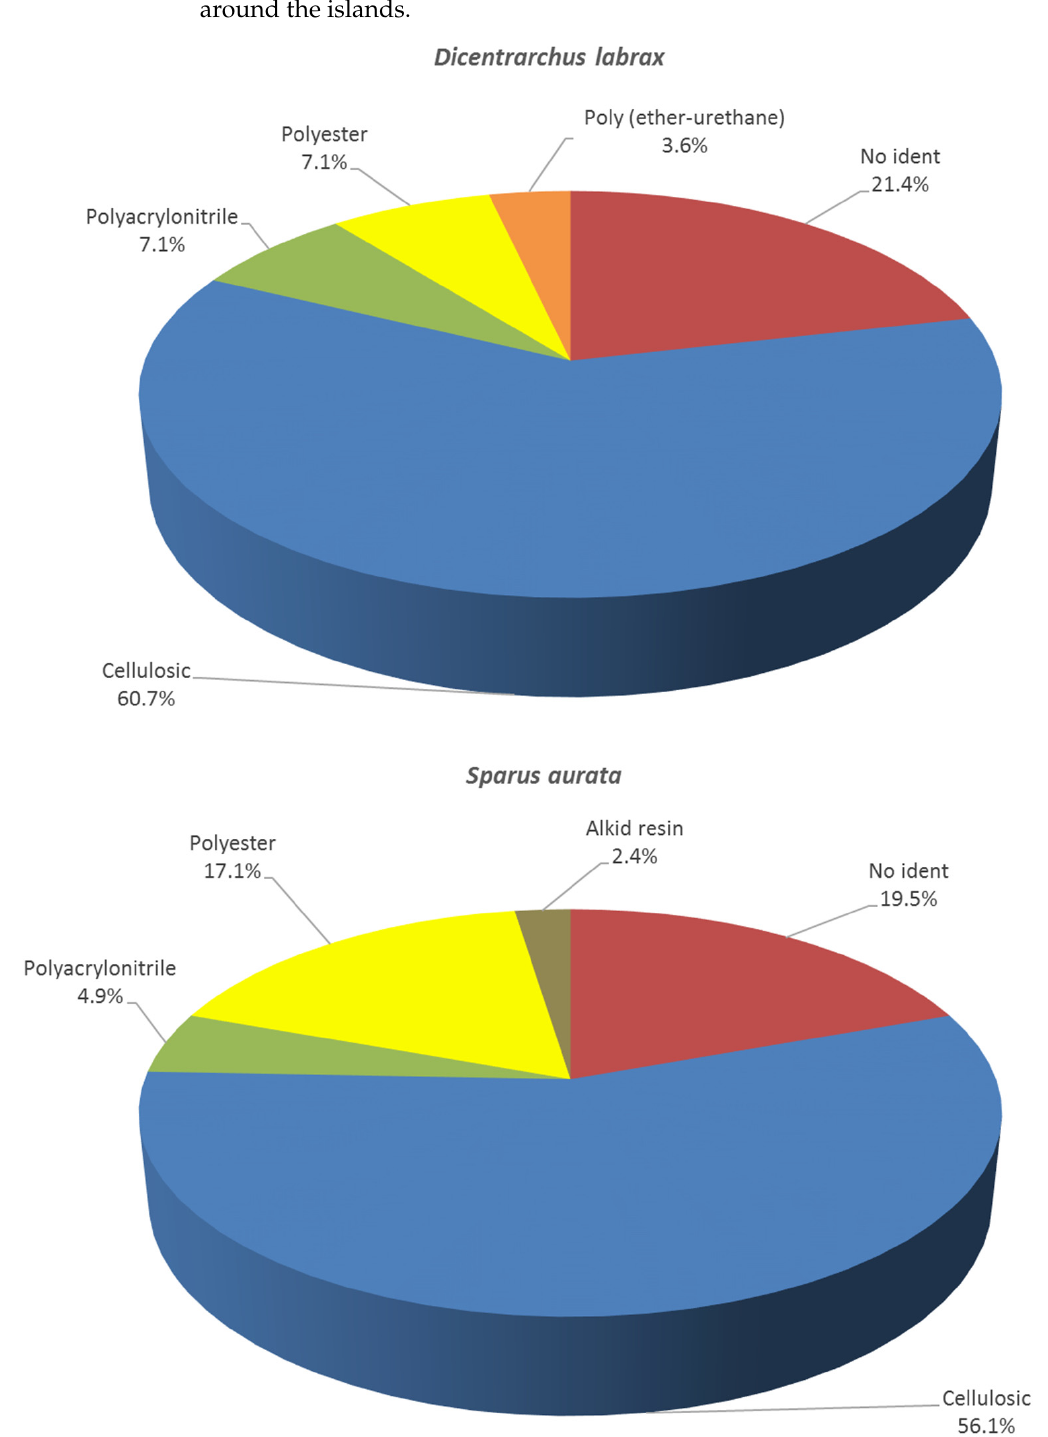
Figure 4. Distribution of the composition of the microfibers found in Dicentrarchus labrax ( n = 41) and Sparus aurata within this study ( n = 45). No-ident: Not identified.